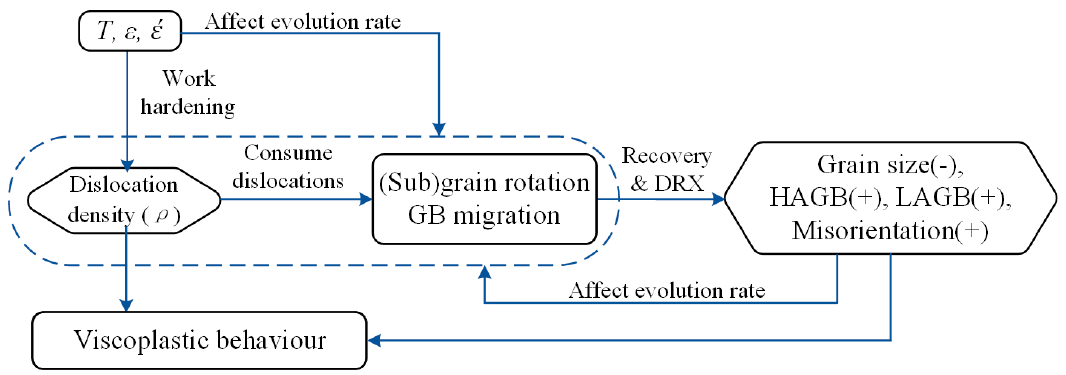
Figure 12. Relationship between external parameters and microstructural variables.